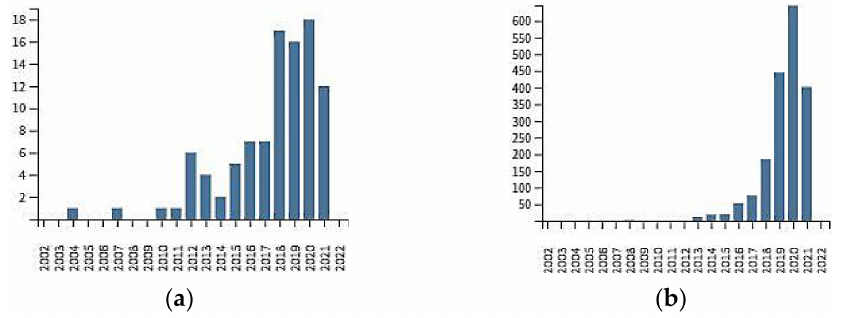
Figure 3. PHM citation report for renewable energy systems using machine learning results from the web of science core collection between 2002 and 2021. ( a ) Total publication per year; ( b ) Sum of times cited by